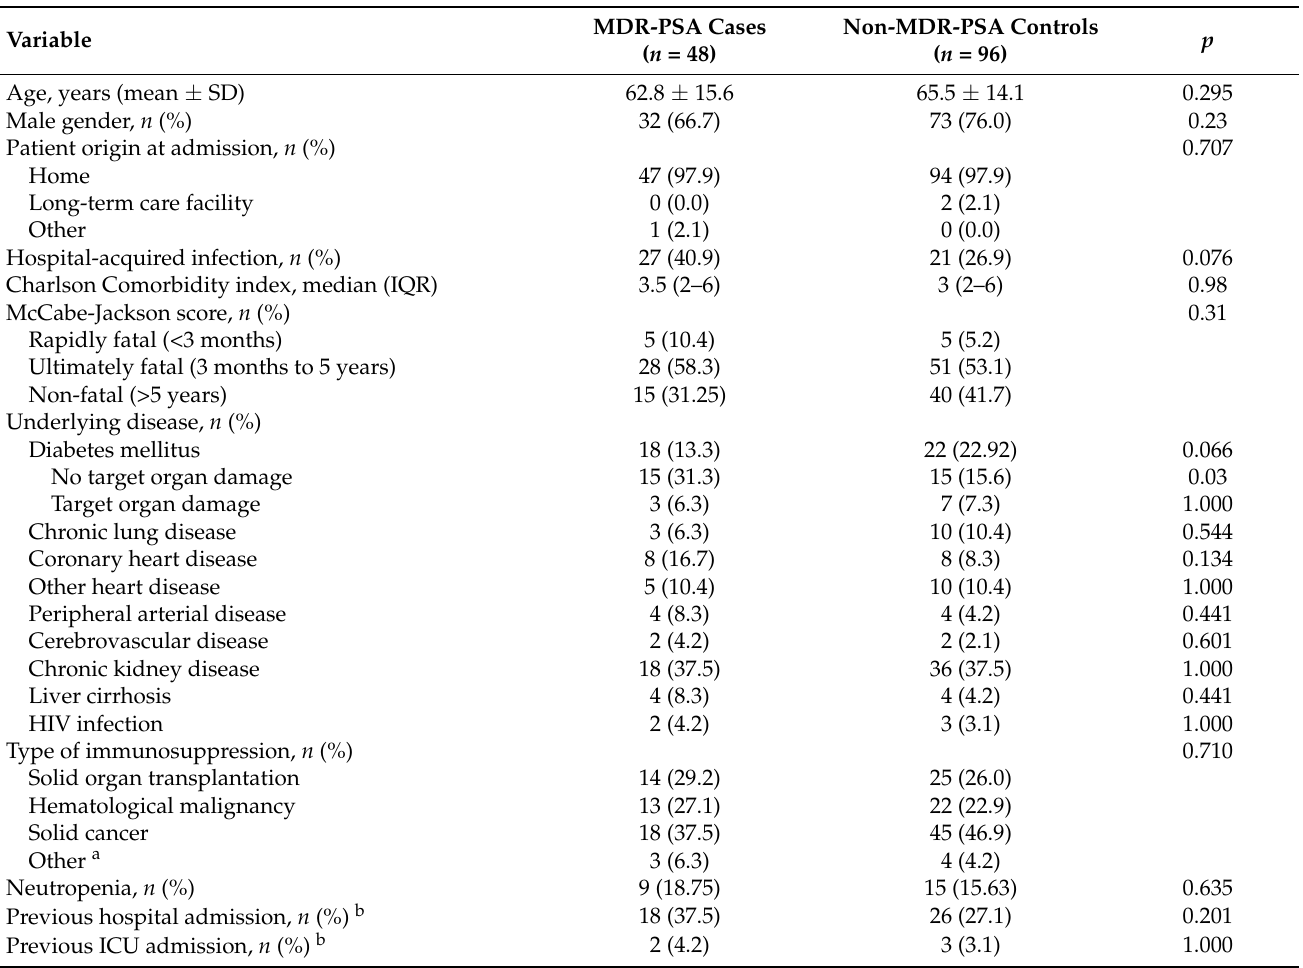
Table 1. Comparison of demographics and baseline patient characteristics of MDR-PSA cases and non-MDR-PSA